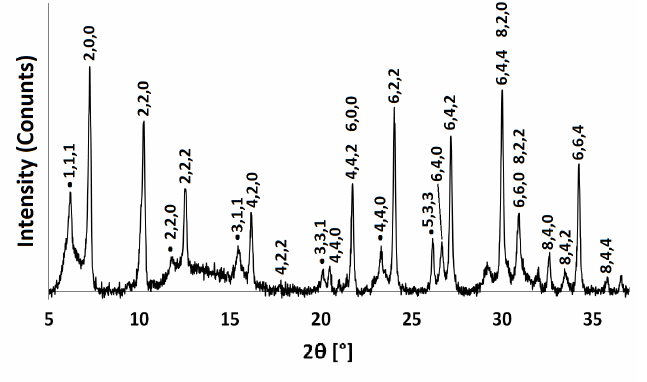
Figure 3. PXRD pattern for Na-A synthesised at 40 ◦ C for 48 h. Characteristic Faujasite (FAU) framework peaks are indexed with black